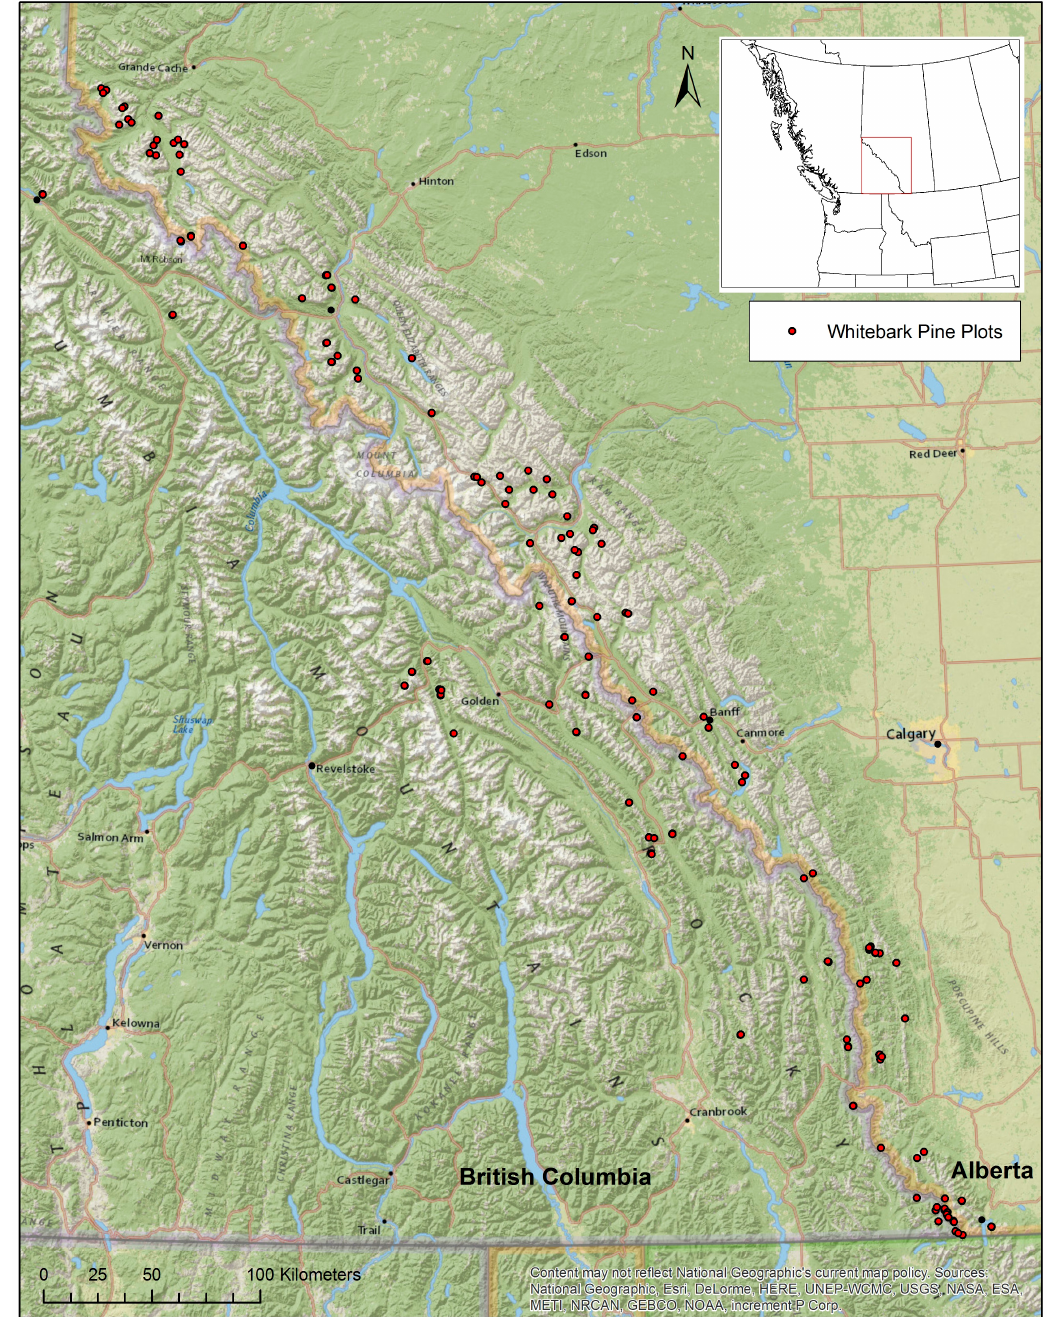
Figure 1. Whitebark pine study sites. The inset map shows the study area map location in red [26]. Table 1. Predictor and response variables.